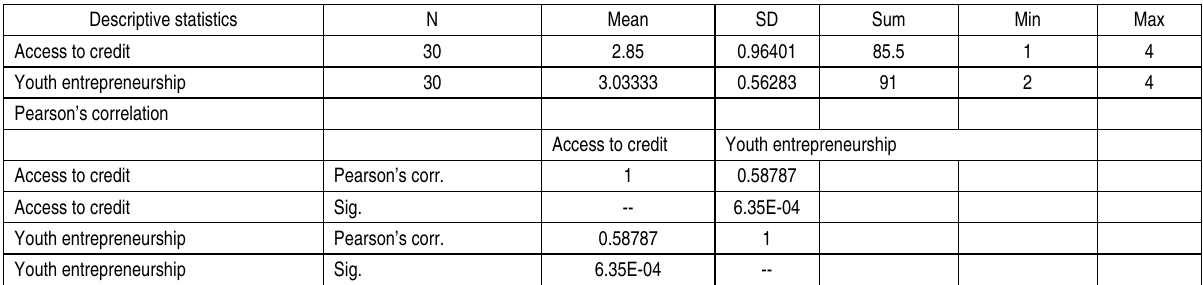
Table 2. Correlation between Youth Entrepreneurial Development and access to